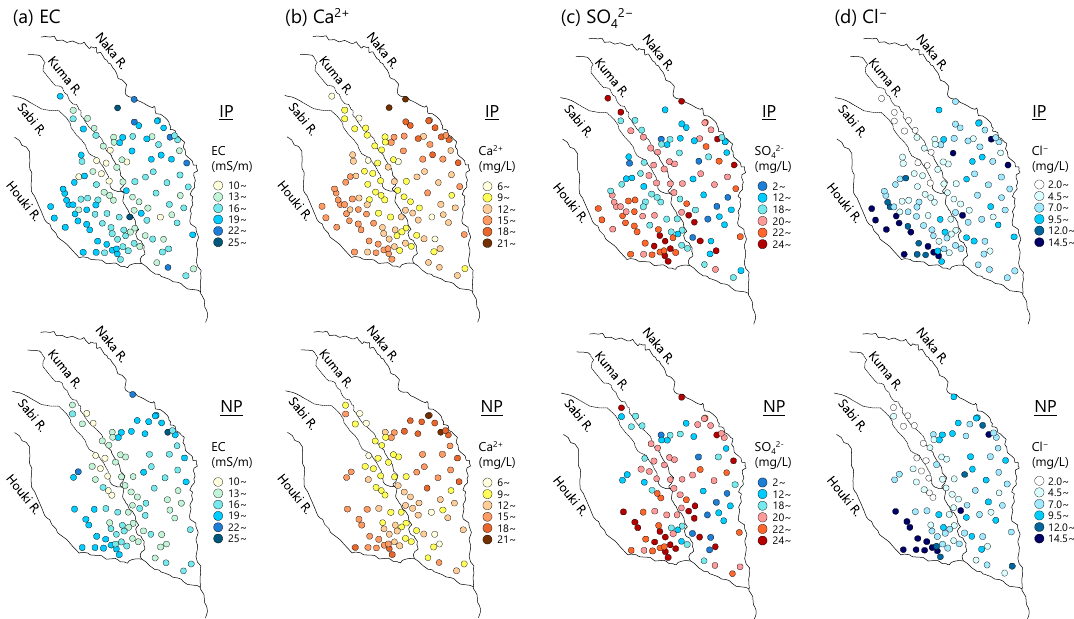
Figure 7. Distributions of ( a ) EC, ( b ) Ca 2 + , ( c ) SO 42 − , and ( d ) Cl − concentrations in the groundwater. The upper and lower maps show the data in the IP and NP, respectively.